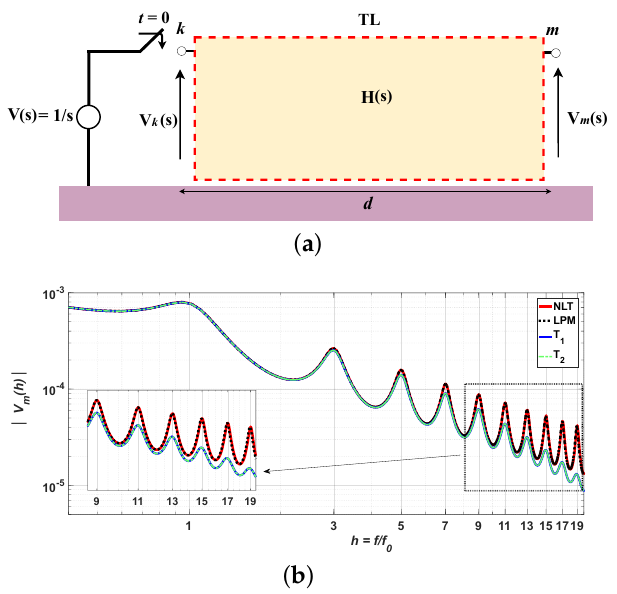
Figure 7. ( a ) Black-box TL modeled by H( s ); ( b ) Magnitude of V m ( s ) for the LPM, BM, T 1 and T 2